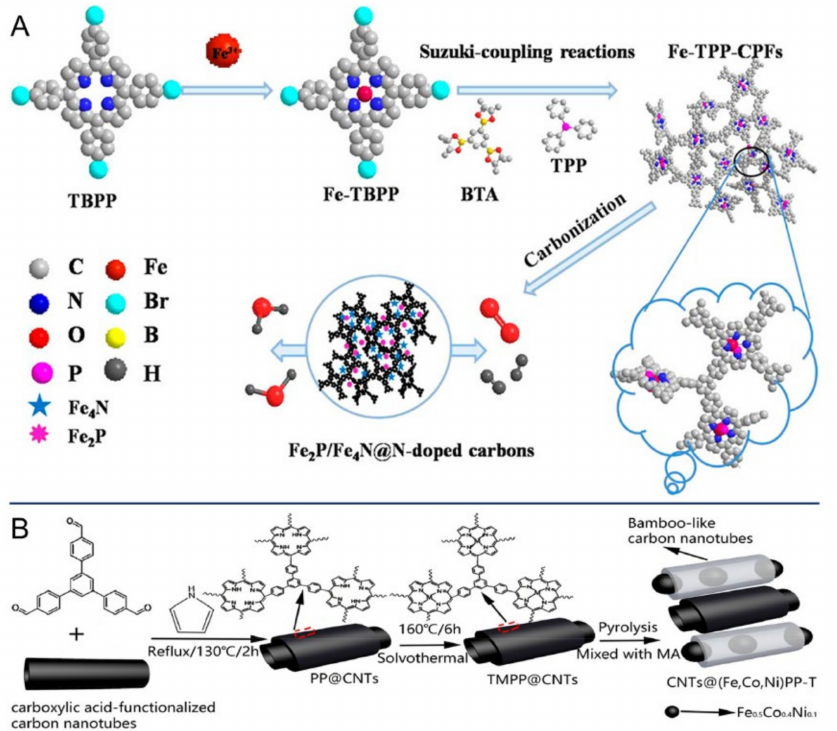
Figure 17. ( A ) Synthesis of Fe-porphyrin-based COFs and corresponding Fe 2 P/Fe 4 N@N-doped car- bon electrocatalysts. Reprinted with permission from ref. [102]. Copyright 2017 American